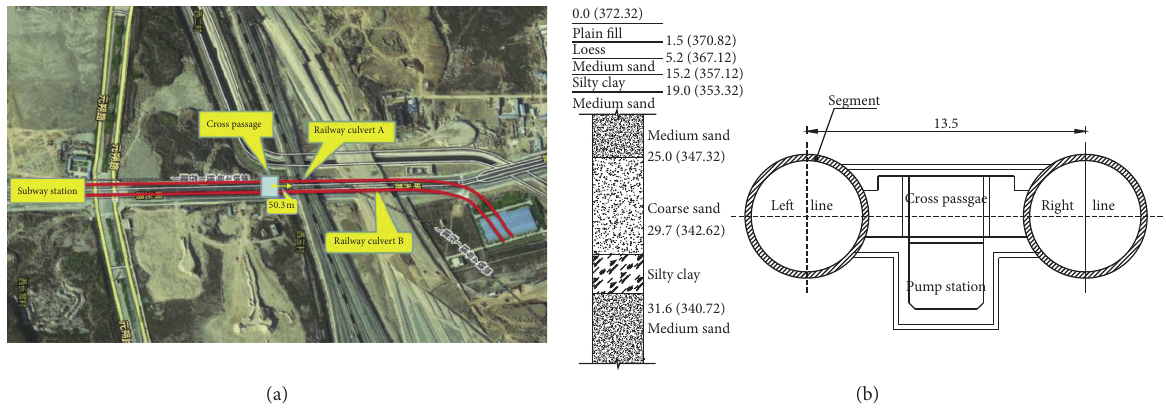
Figure 1: Metro section and cross passage: (a) plan view and (b) strata distribution and relative position of the cross passage and tunnel (unit: